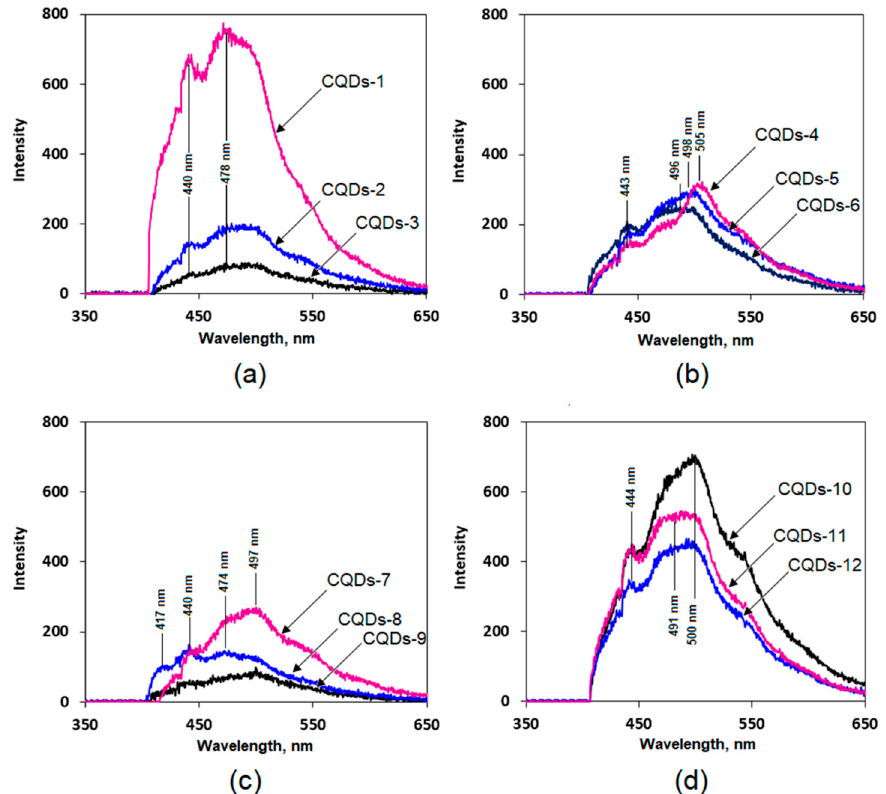
Figure 3. Fluorescent Spectra of the Obtained Chitosan-Based CQDs ( a ) CQDs1-3 samples, ( b ) CQDs4-6 samples, ( c ) CQDs7-9 samples and ( d ) CQDs-10-11 samples.